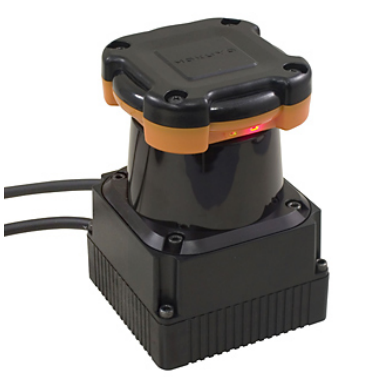
Figure 1. Hokuyo UTM-30LX.